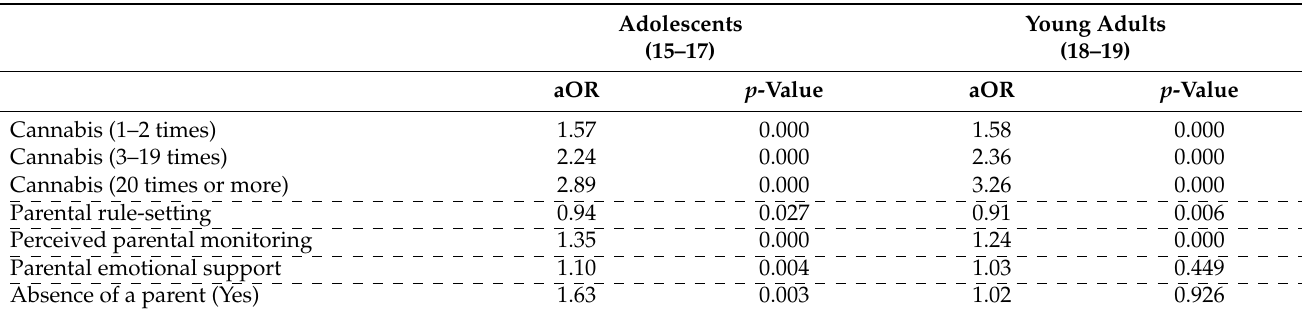
Table 6. Binary logistic regression models between cannabis use, parenting indicators, and violent behaviour in the past 12 months among adolescents and young